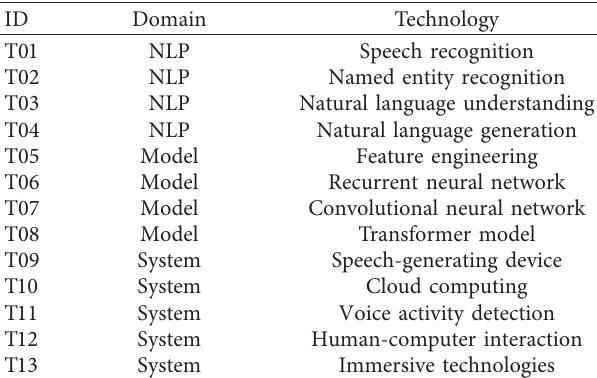
Table 10: TFM technologies.